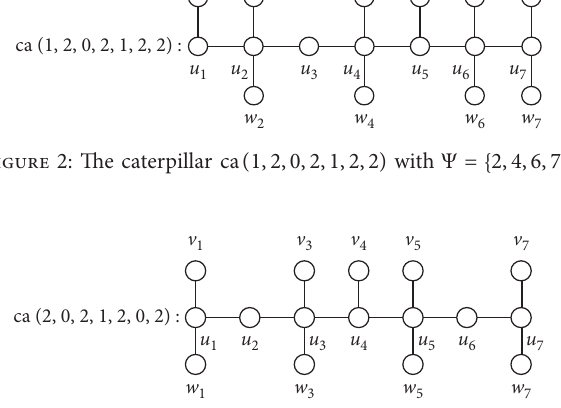
Figure 3: The symmetric caterpillar ca ( 2 , 0 , 2 , 1 , 2 , 0 , 2 )